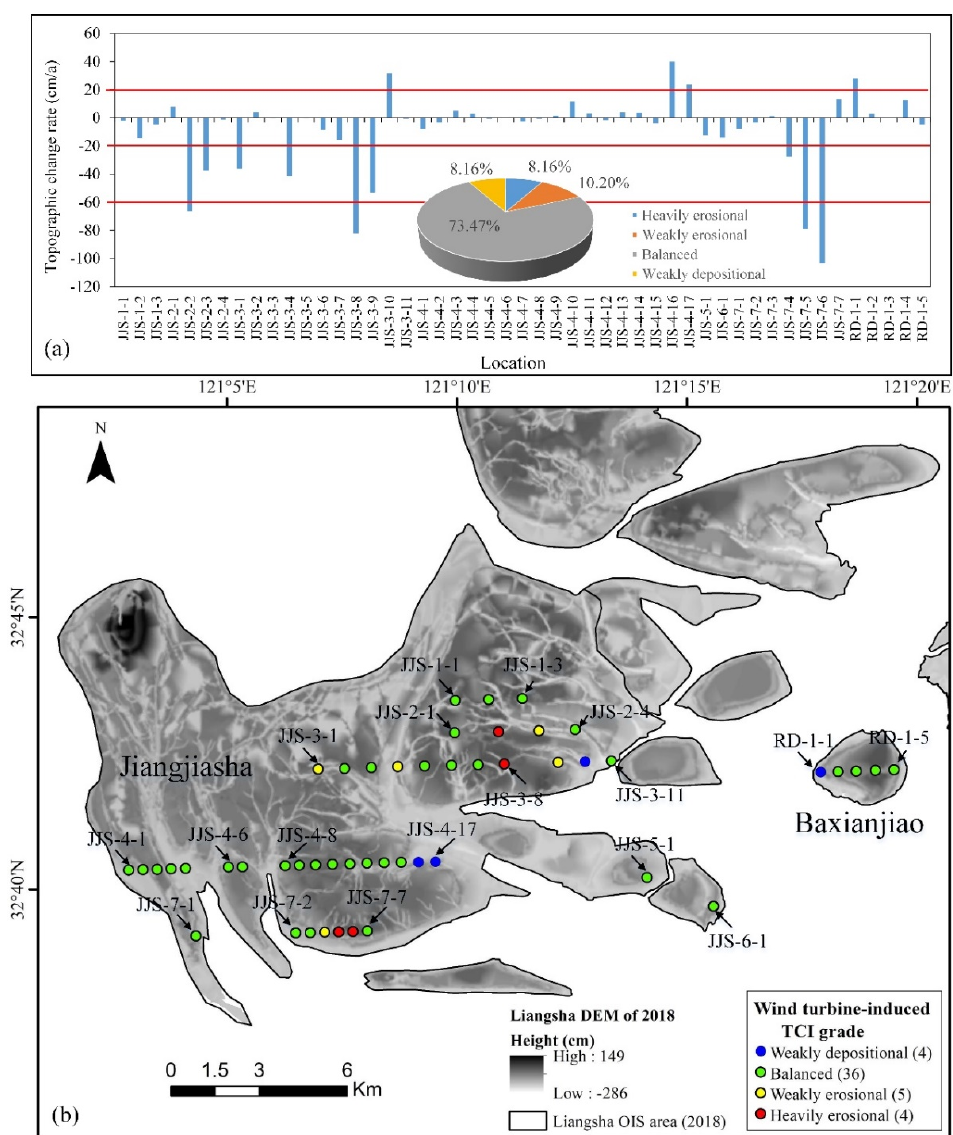
Figure 8. Topographic change caused by the construction of wind turbines. ( a ) TCR of the 49 wind turbines. Red lines show the threshold for different TCR intervals defined in Table 1. Additionally, the pie chart illustrates the ratio of the wind turbines in different TCI grades. ( b ) Spatial distribution of their TCI grades.